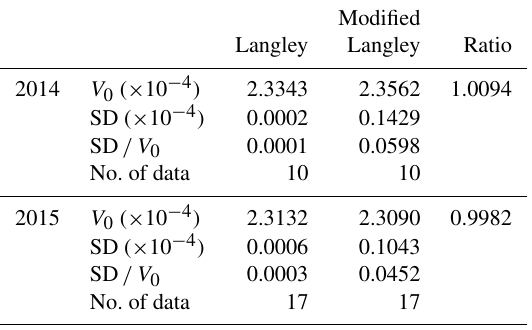
Table 6. Calibration constant at 940nm by the modified Langley method using the data taken at MLO.